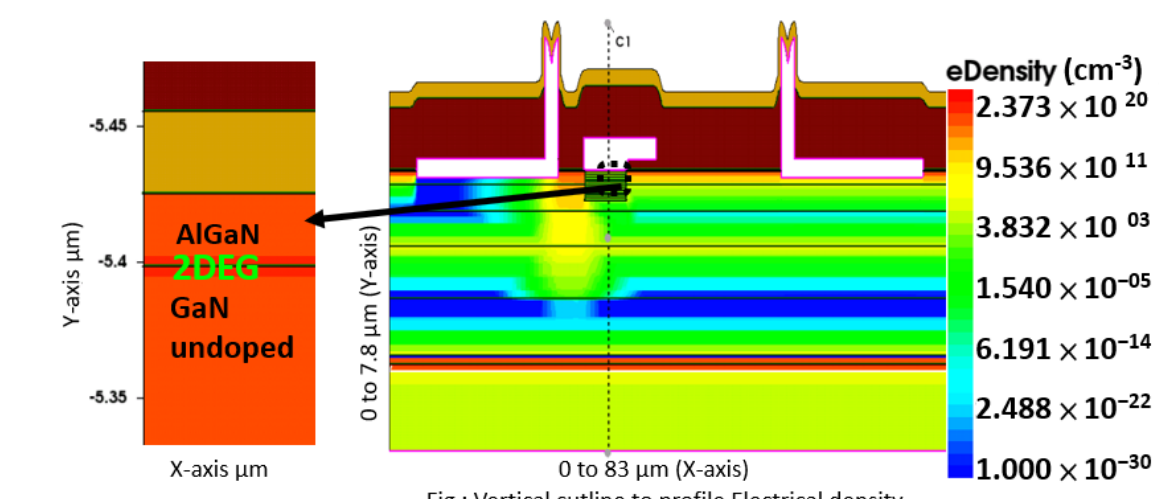
Figure 4. 2DEG density device cut profile.